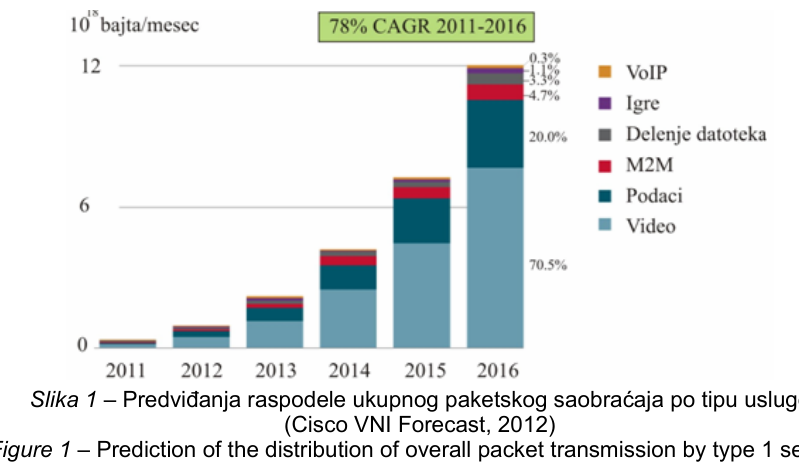
Figure 1 – Prediction of the distribution of overall packet transmission by type 1 service (Cisco VNI Forecast,